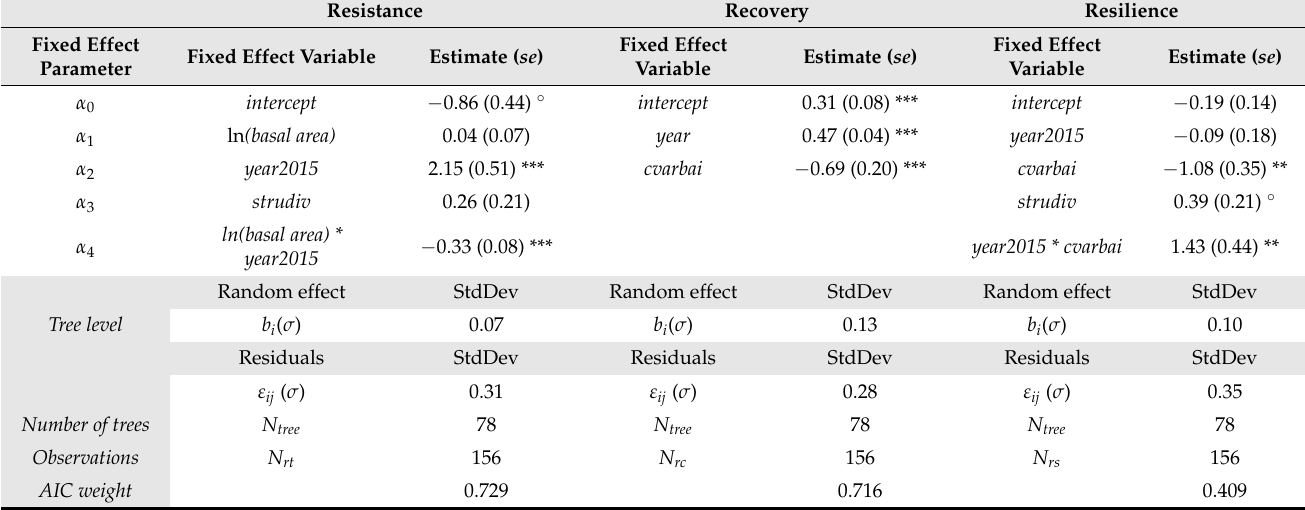
Table 3. Parameter estimates and standard errors ( se ) of the best models for resistance (left), recovery (center), and resilience (right) resulting from the multi-model inference. α are the regression coefficients of the fixed covariates, b represents the random intercept, ε is the error term, and N stands for the number of trees, respectively the number of observations. Significance levels: *** = 0.001, ** = 0.01, ◦ =